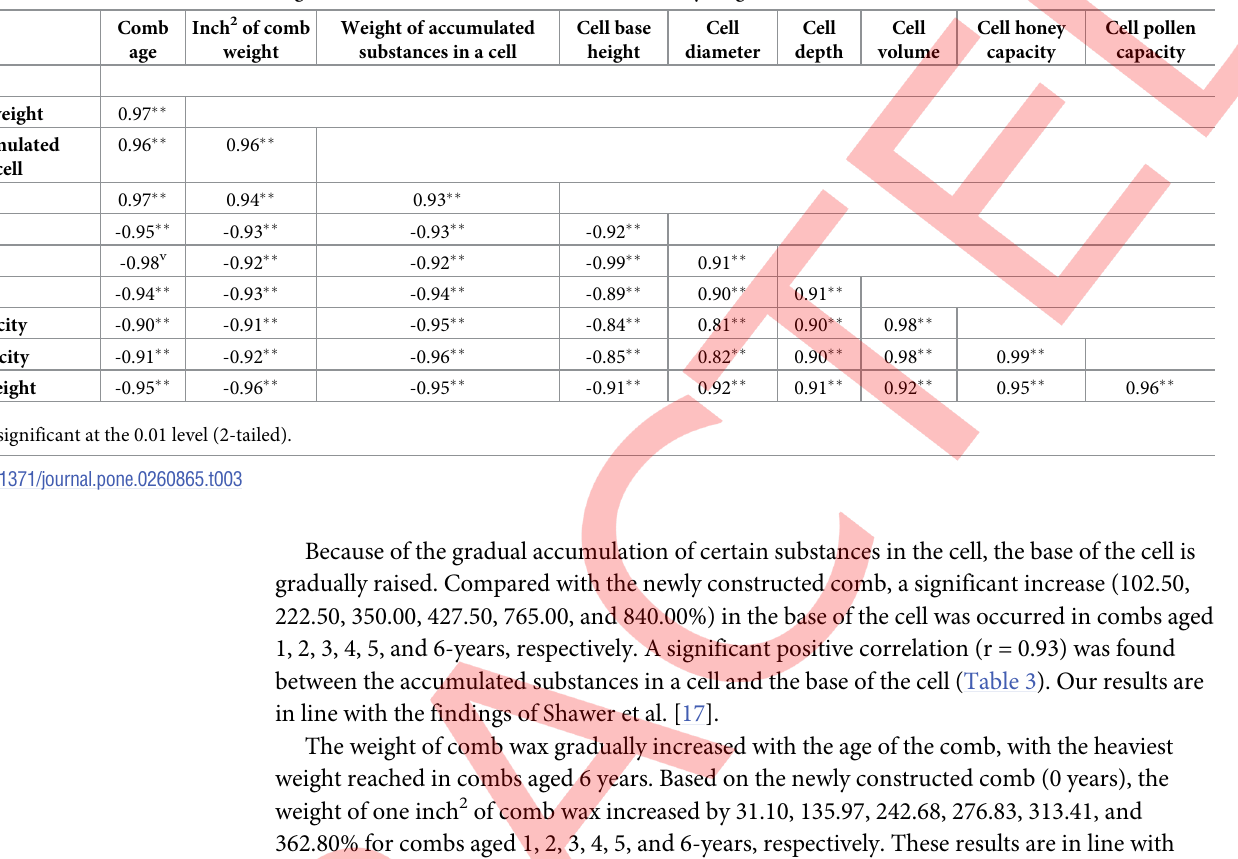
Table 3. Pearson correlation coefficients for comb age, measurements of comb cells, and worker body weight.